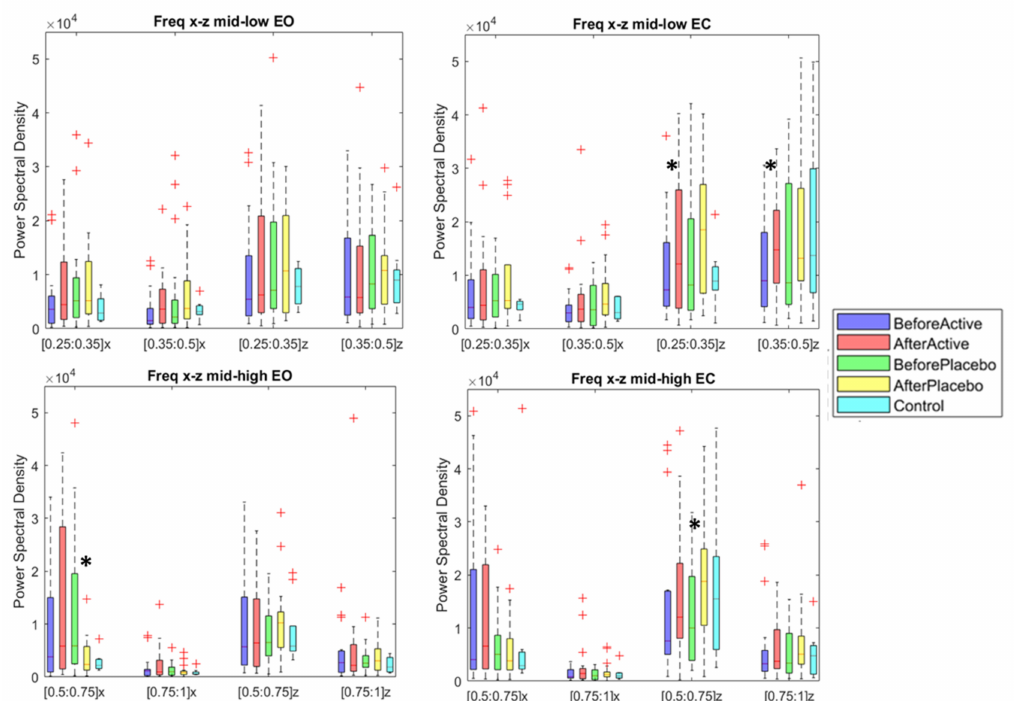
Figure 2. Romberg Test. Differences in the treatments effect and controls accounting for the low and high bands of the postural oscillation. Results are reported in both the medial-lateral component (x) and anterior-posterior component (z). *: Statistically significant difference ( p < 0.05) between the before-after condition with the Wilcoxon signed rank test ( p < 0.05). red † indicate the